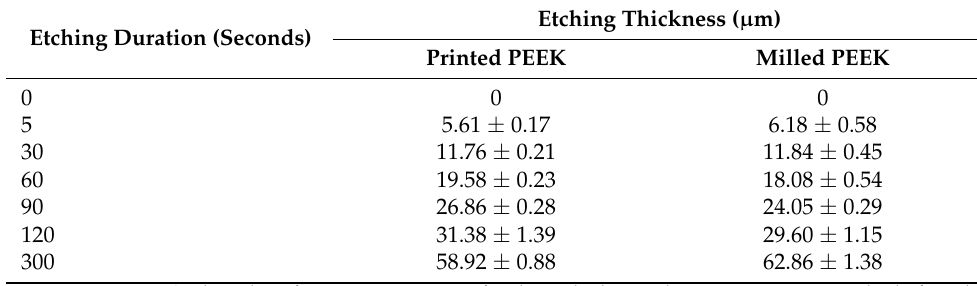
Figure 5. The SEM images showing the cross-section morphology of the etched PEEK before and after the treatment of the primer at ×1000 magnification. P : etched printed PEEK; M : etched printed PEEK; PV : etched printed PEEK with the treatment of the primer; and MV : etched milled PEEK with the treatment of the primer. The dotted lines indicate the bottom of the etched pores. Table 3. Sulfuric acid etching time points applied to the different groups.